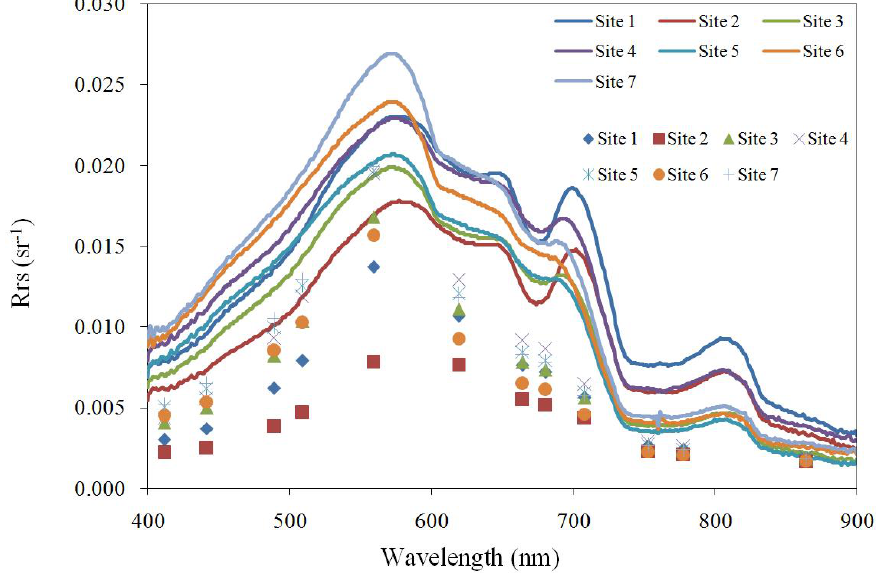
Figure 6. Comparison of the BEAM atmospheric correction and in situ measured reflectance spectra measured on 11 June 2007. The lines represent the reflectance spectra by measurements. The marks represent the atmospheric corrections by BEAM.